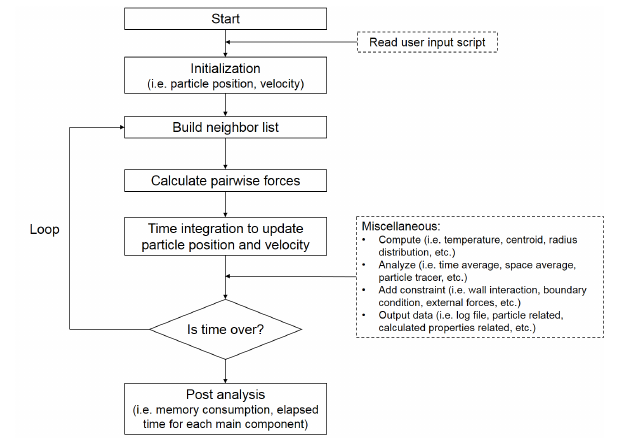
Figure 2. A flow chart of the computational steps with